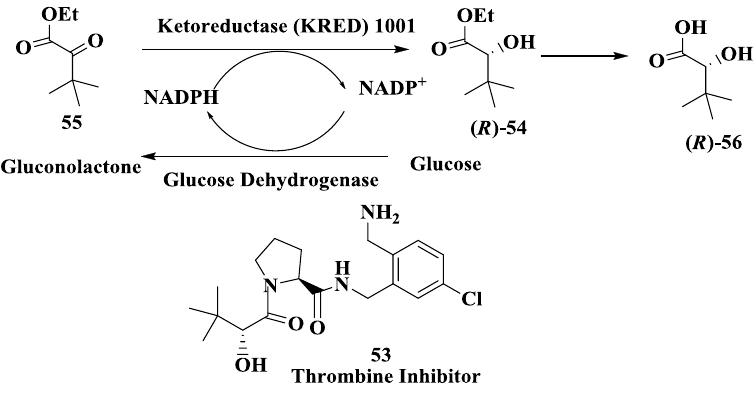
Figure 14. Thrombin inhibitor: Enzymatic preparation of ( R )-2-Hydroxy-3,3-dimethylbutanoic